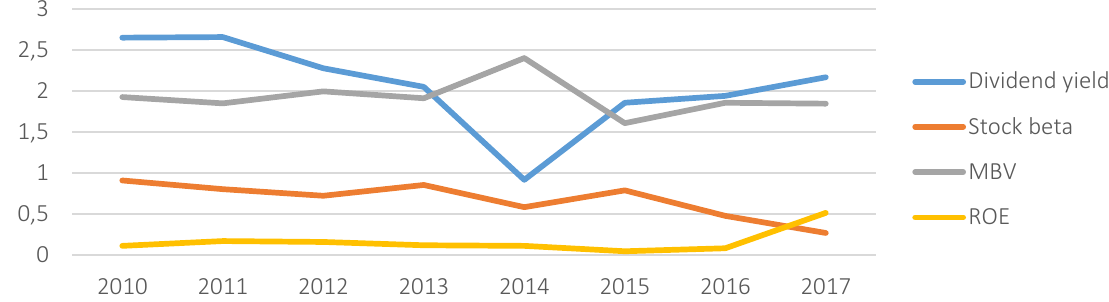
Figure 1. Mean (all data) of dividend yield, stock beta, MBV, and ROE